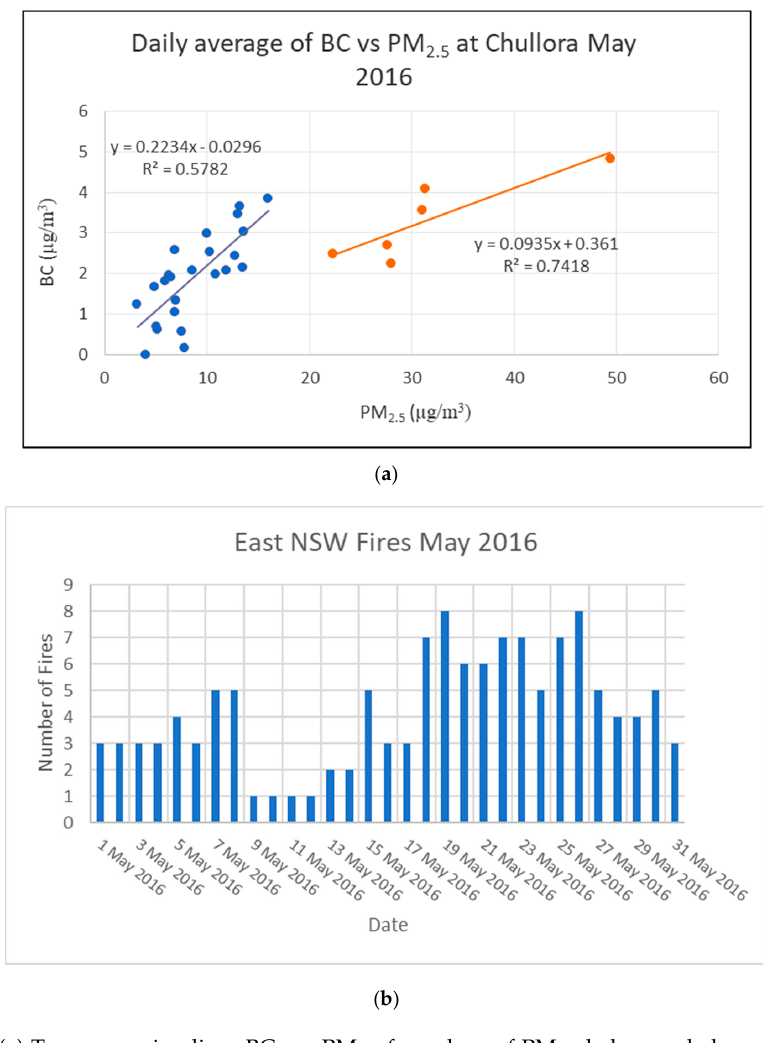
Figure 14. ( a ) Two regression lines BC vs. PM 2.5 for values of PM 2.5 below and above 20 µ g / m 3 at Chullora; and ( b ) daily number of fires for May 2016 in the NSW East.